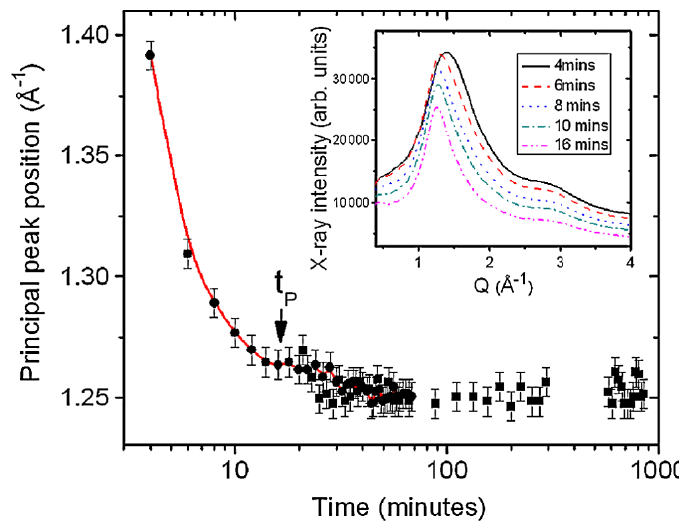
Figure 21. Position of the principal leak in S ( Q ) as a function of log(time). The parameter t P marks the time at which the peak position plateaus and a viscous amorphous gel forms from the solution. The inset shows the X-ray intensity as a function of time during the early stages of the process where the main changes in structure occur. Data retrieved from [56].